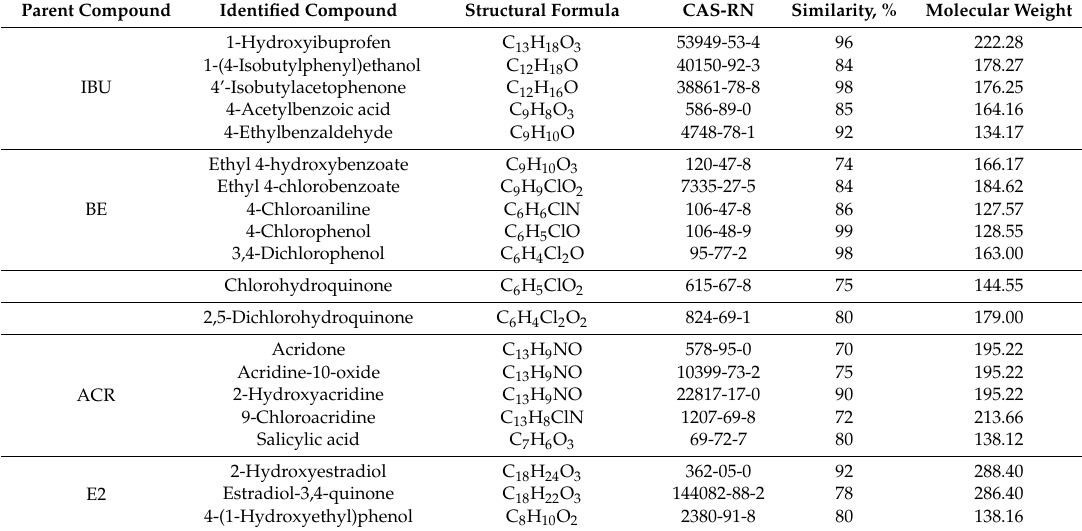
Table 1. Identified CECs by-products during the performed experiments.